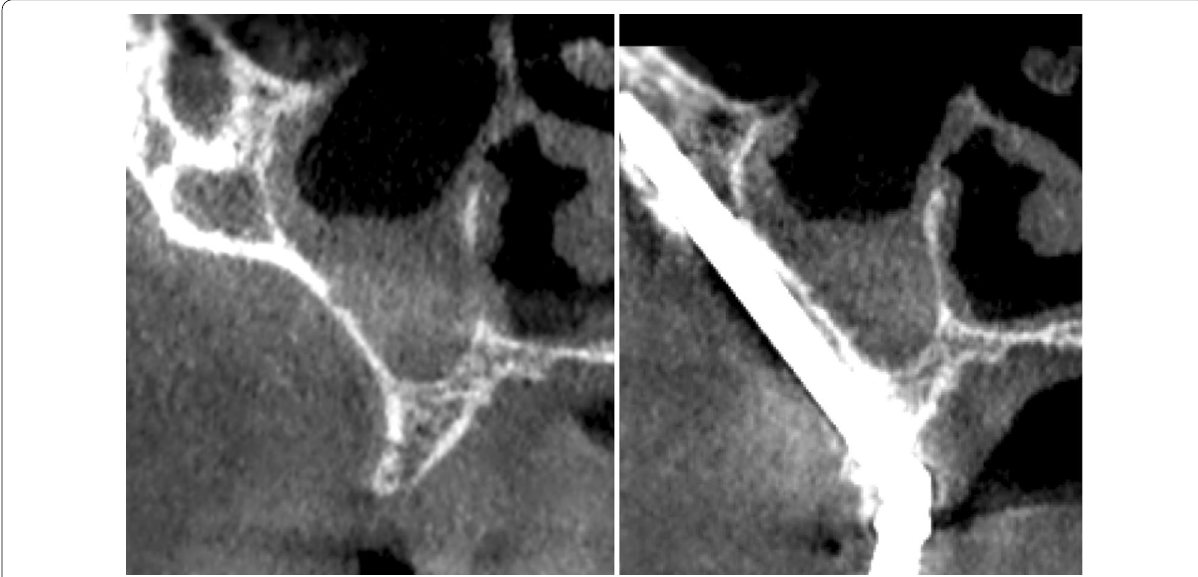
Fig. 7 Preoperative CBCT images are compared to one‑year postoperative images. Although there is postoperative sinus opacity, the Modified Lund–Mackay score [20] would be negative because the referred opacity existed before the surgery and did not increase